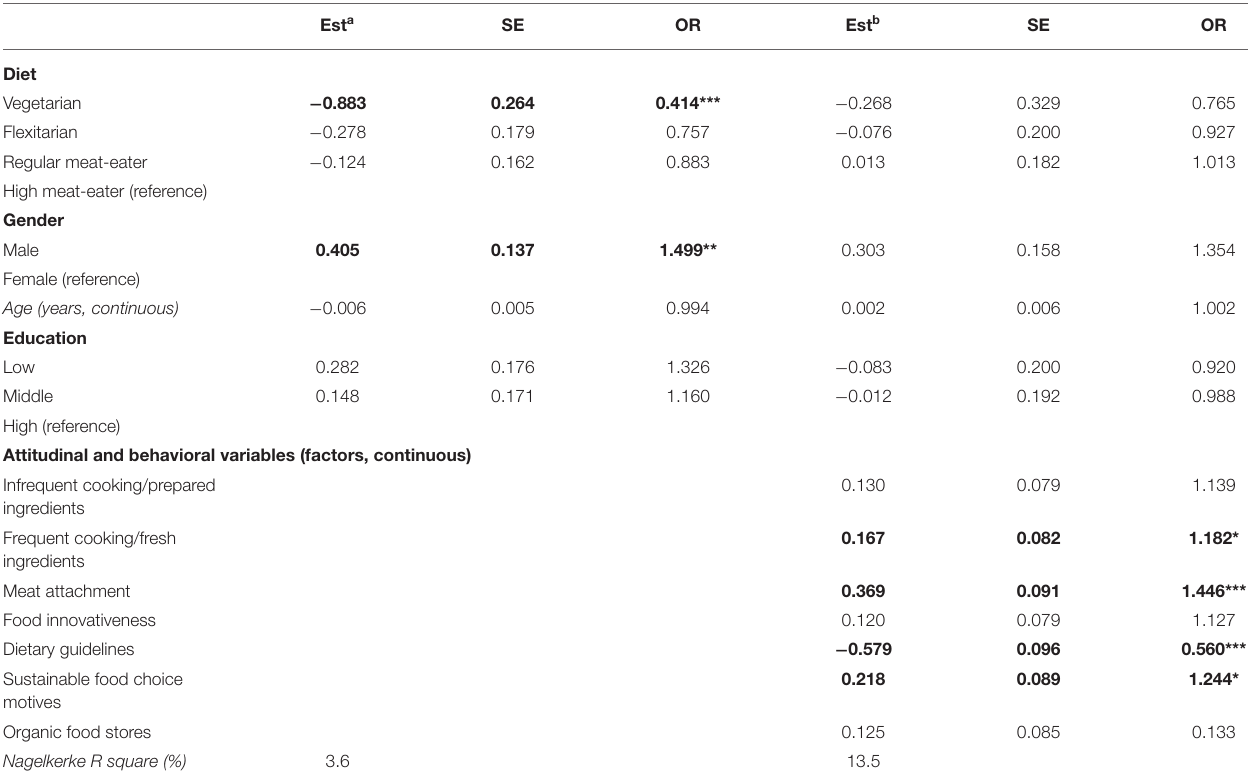
TABLE 10 | Results of an ordinal regression analysis predicting ultra-processed beverage consumption ( N =